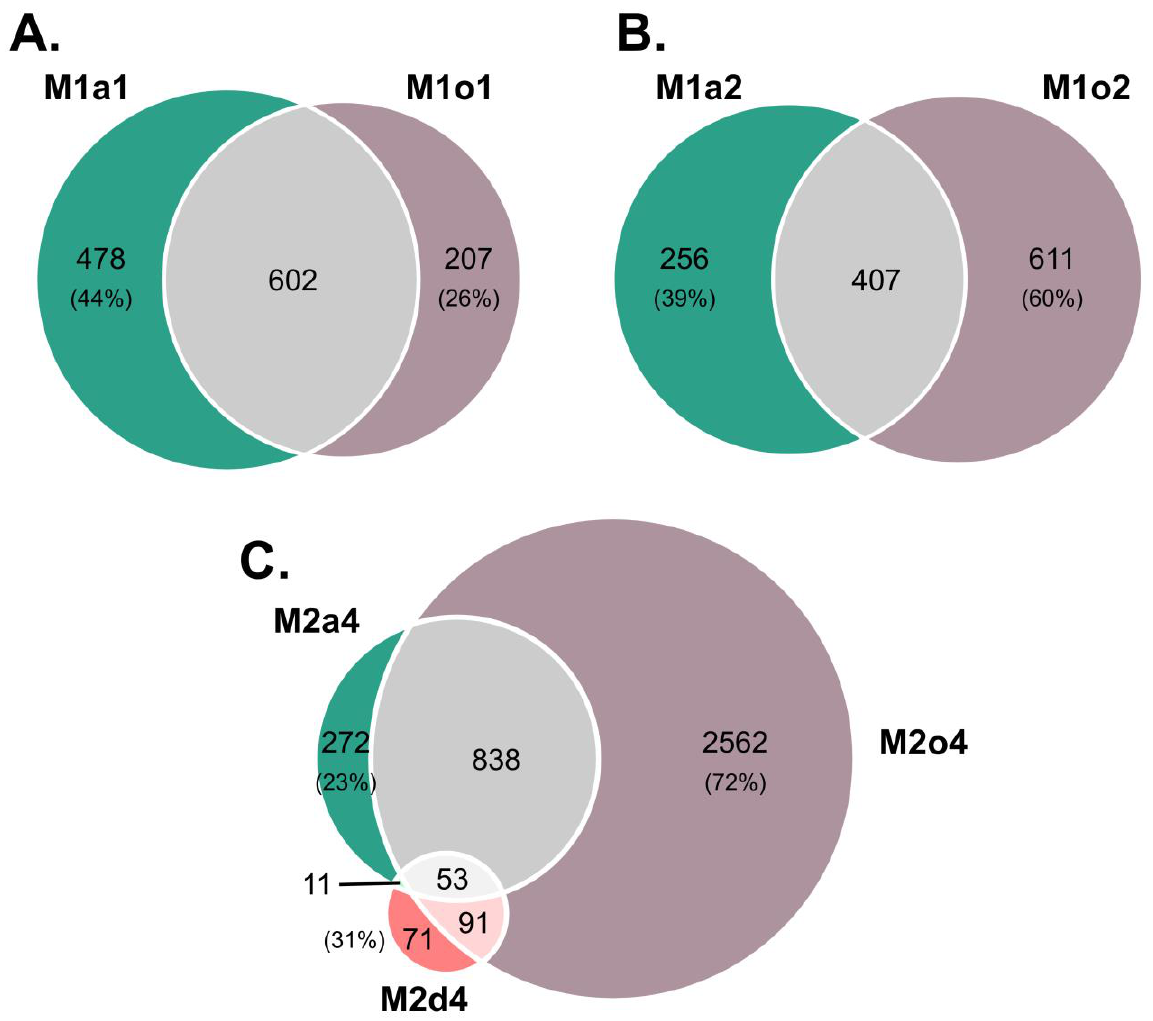
Figure 1. Weighted Venn diagrams of specific and overlapping differentially expressed genes (DEGs) found in the ovules of apomictic L. multiflorum (M), facultative apomictic L. dodartii (d), and sexual L. auriculifolium (a) and L. ovalifolium (o). DEGs were filtered by |log2 fold-change (log2FC)| > 2. Number of overlapping and specific DEGs in: A. L. multiflorum in S1 relative to L. auriculifolium in S1 (M1a1; green) and to L. ovalifolium in stage S1 (M1o1; purple); B. L. multiflorum in S1 relative to L. auriculifolium in S2 (M2a2; green) and to L. ovalifolium in S2 (M1o2; purple); C. L. multiflorum in S2 relative to L. auriculifolium in S3/S4 (M2a4; green), to L. ovalifolium (M2o4; purple) and to L. dodartii in S4 (M2d4; red).